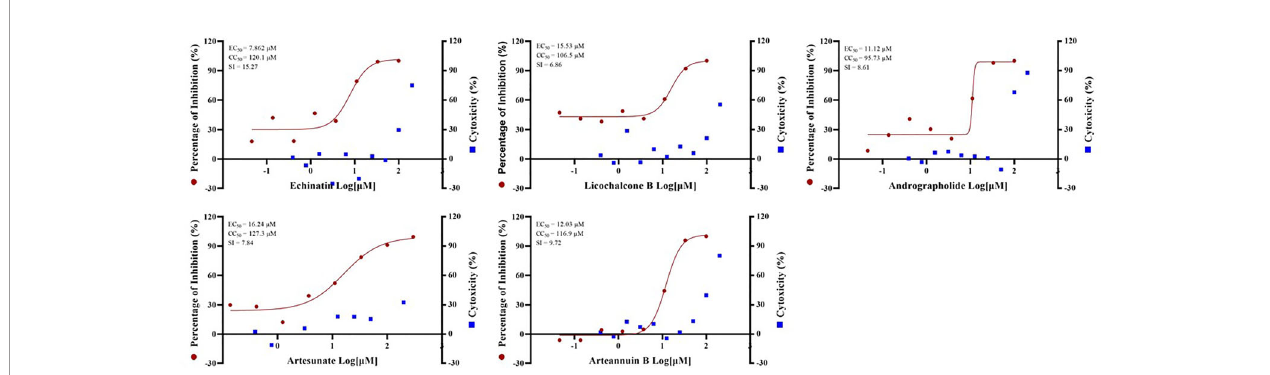
FIGURE 4 | The EC 50 and Time-of-addition assay of the fi ve monomer compounds in the “ Three Medicines and Three Prescriptions ” against SARS-CoV-2. Vero E6 cells were infected with SARS-CoV-2 at an MOI = 0.01 in the treatment of different doses of the indicated antivirals for 24h. The viral yield in the cell supernatant was then quanti fi ed by qRT-PCR. The Y axes of the graph represent the average percentage of inhibition of virus production. The experiments were done in